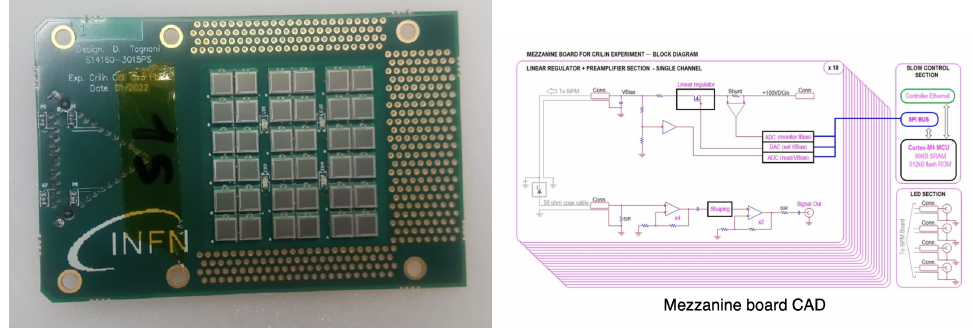
Figure 8. ( Left ): SiPMs board detail, showing the sensor matrices and the LEDs. ( Right ): Mezzanine Boards CAD